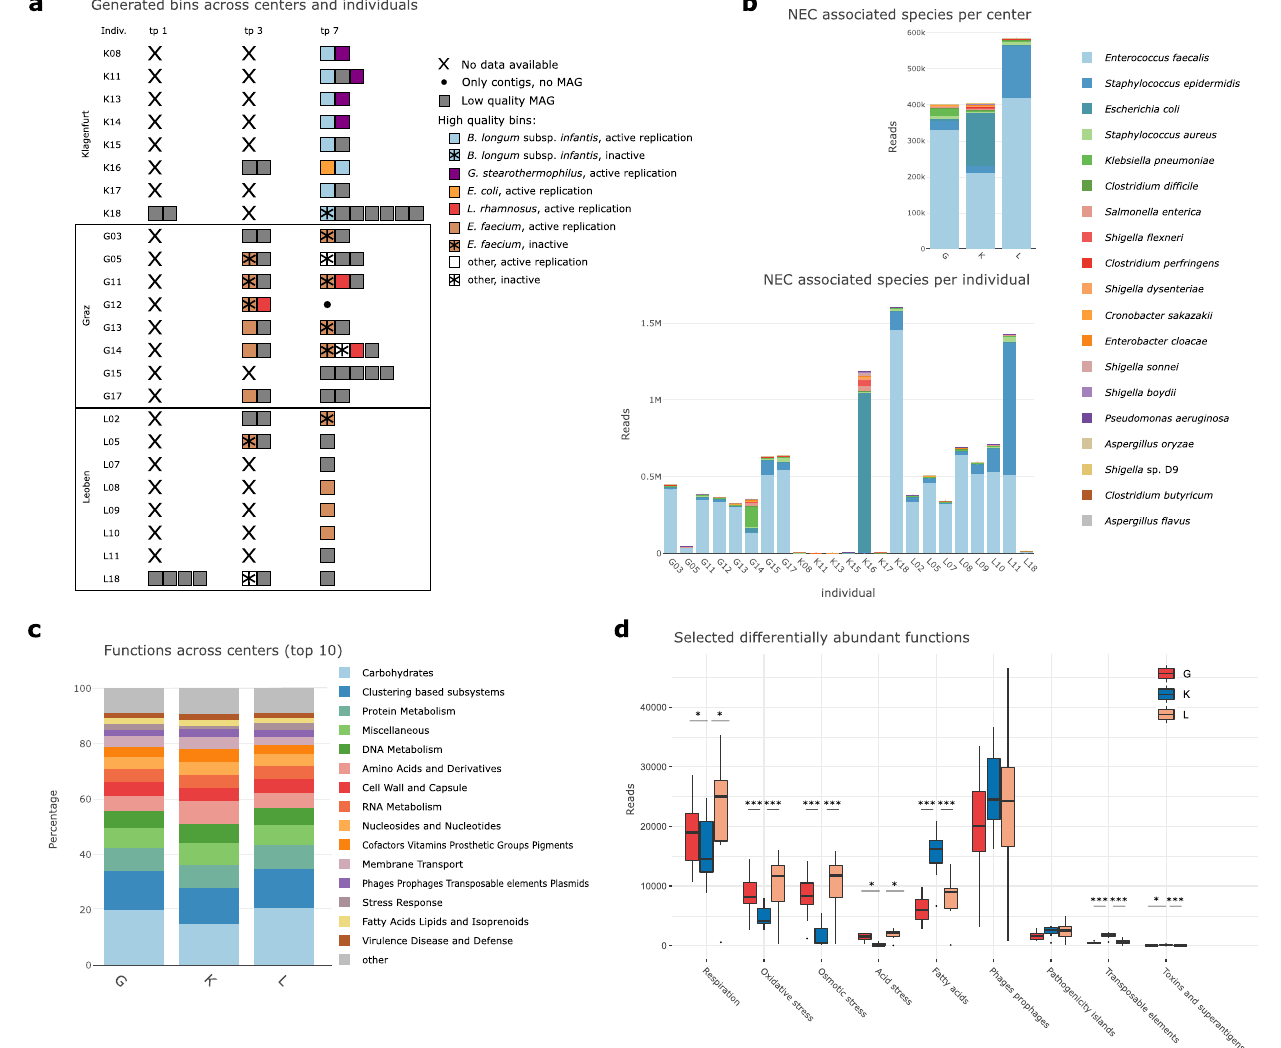
Fig. 3 | Replication values for MAGs, distribution of potentially NEC causing microbes, and speci fi c functions. a Retrieved MAGs per center, individual